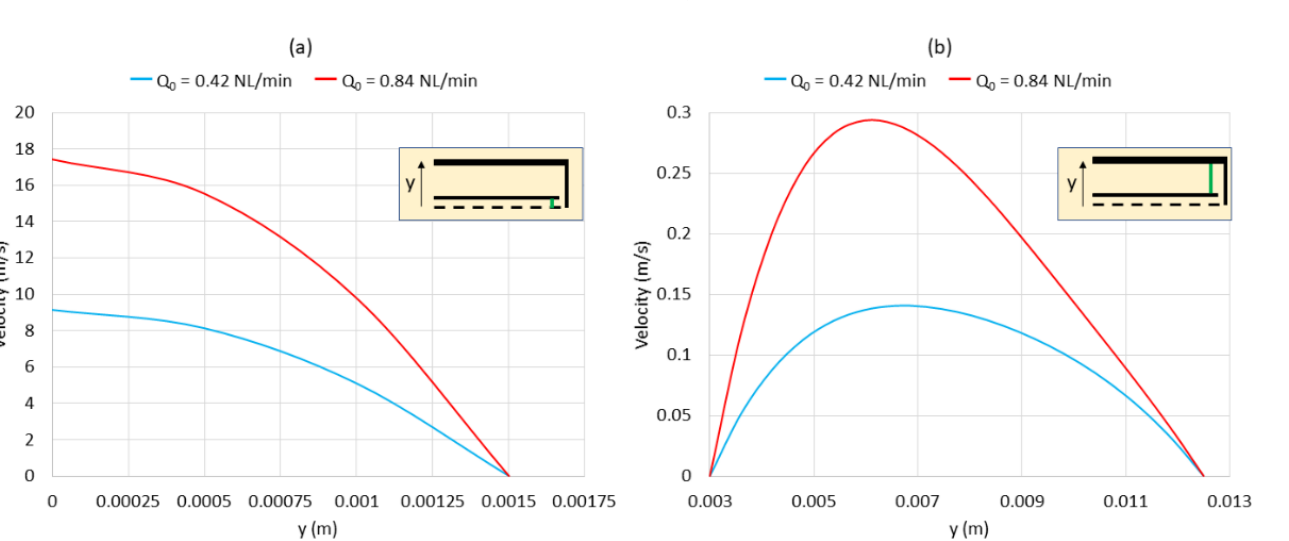
Figure 11. Velocity streamlines in the reactor with a zoom at the bottom part: ( a ) case 1 and ( b ) case 3.